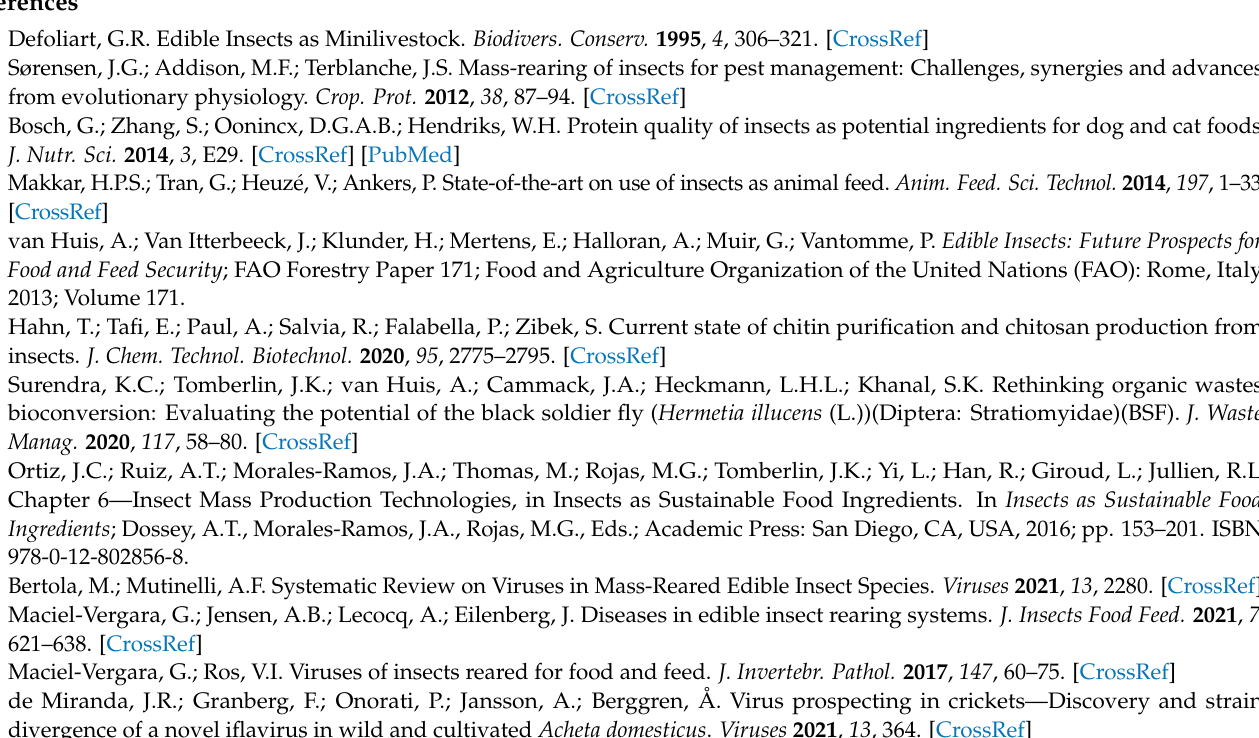
Figure S2: Protein alignment of Argonaute-2; Figure S3: Protein alignment of Dorsal; Figure S4: Protein alignment of Relish; Figure S5: Protein alignment of MyD88; Figure S6: Protein alignment of Cactus; Figure S7: Protein alignment of PGRP-LC; Figure S8: Protein alignment of Imd; Figure S9: Protein alignment of Domeless; Figure S10: Protein alignment of PIAS; Figure S11: Protein alignment of STAT5B; Figure S12: Protein alignment of R2D2; Figure S13: Protein alignment of Lysozyme; Figure S14: Maximum likelihood tree of Dicer proteins; Figure S15: Maximum likelihood tree of Argonaute and Piwi proteins; Figure S16: Maximum likelihood tree of Dorsal and Relish